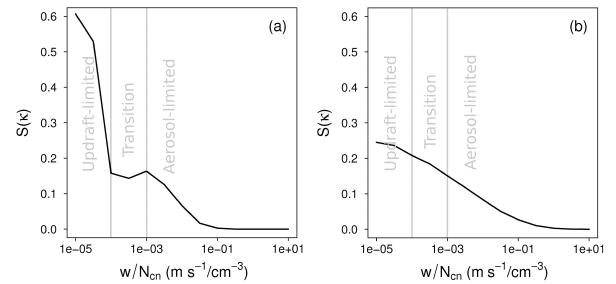
Fig. 1. The sensitivity of the droplet number to κ , S ( κ ), computed from parcel model output, as a function of the ratio w / N cn , for κ =0.2 to 0.5. The sensitivities were averaged over all initial val- ues of T . Results are shown for (a) input aerosol size distributions with r g =0.06µm, and (b) averaged over all initial values of r g . The Reutter et al. (2009) regimes are